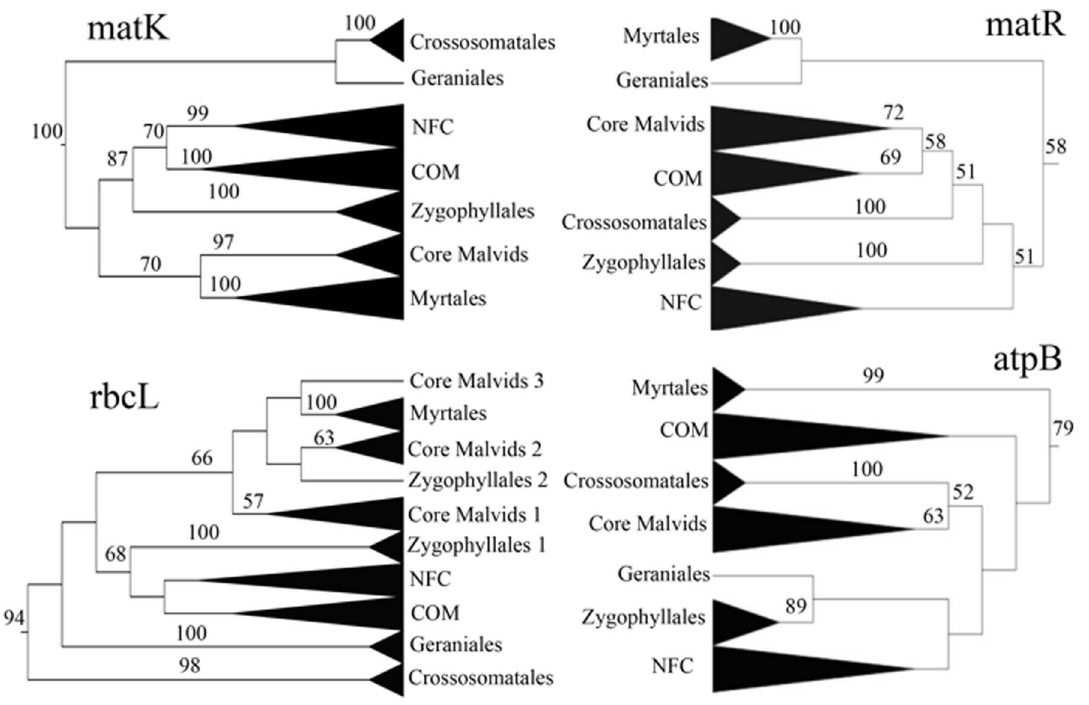
Oxalidales. NFC (Nitrogen Fixing Clade): Rosales, Fabales, Cucurbitales, and Fagales. The core malvids group and the Zygophyllales were not recovered as monophyletic lineages in the rbcL partition analysis.